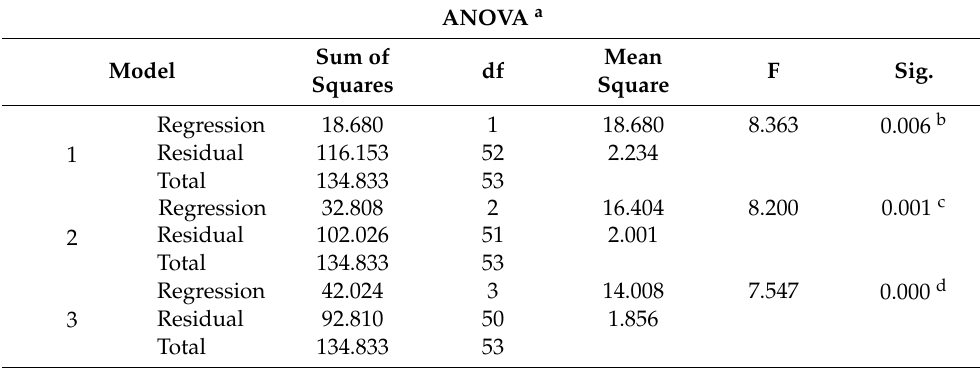
Table 4. Analysis of Variance (ANOVA) of the regression